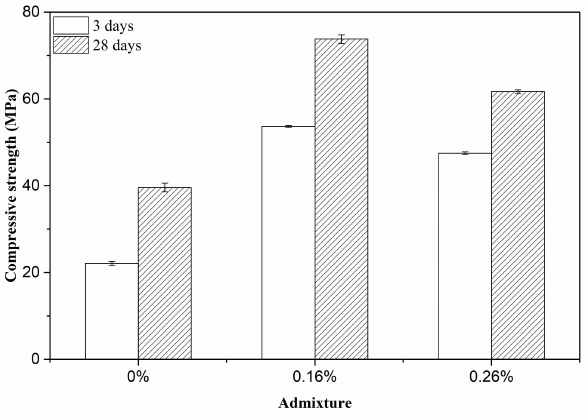
Figure 5. Influence of modifier on the compressive strength of MOS cement